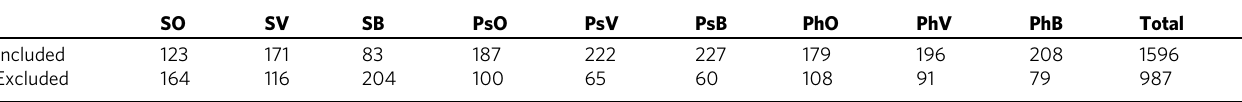
Table 1 Number of narratives included in and excluded from Phase 1, by scenario.